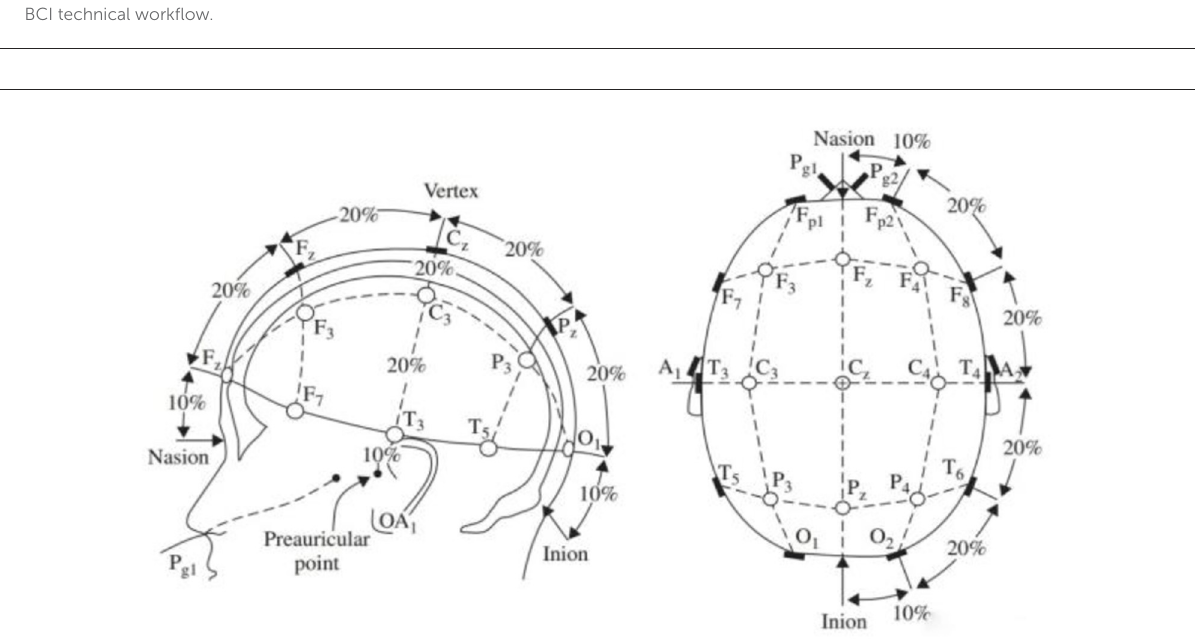
FIGURE3 International 10–20 standard electrode lead